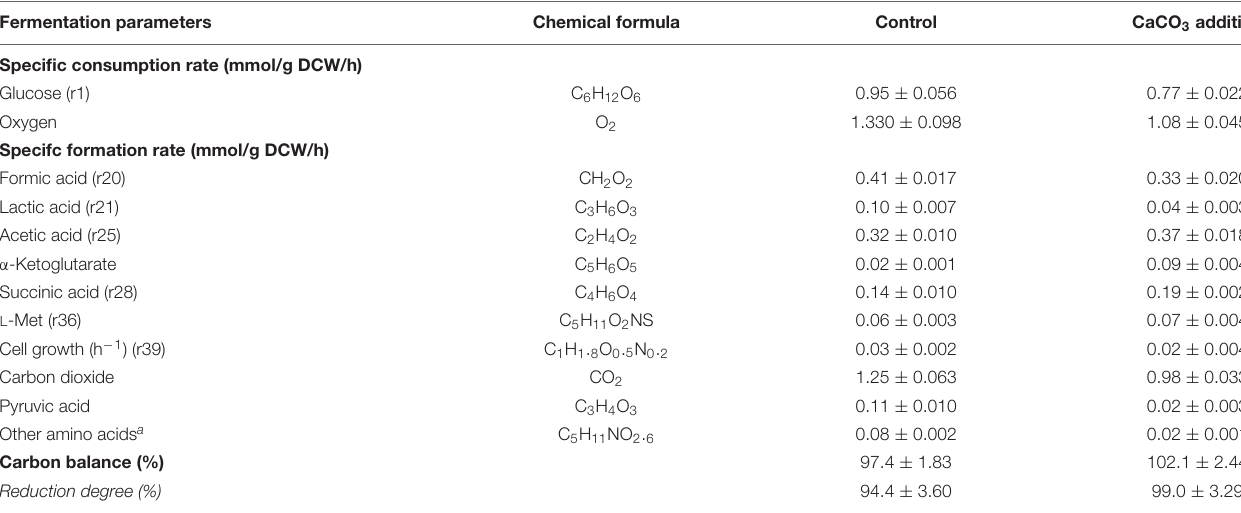
TABLE 3 | Rate parameters of metabolic reaction in E. coli W3110-BL. Fermentation